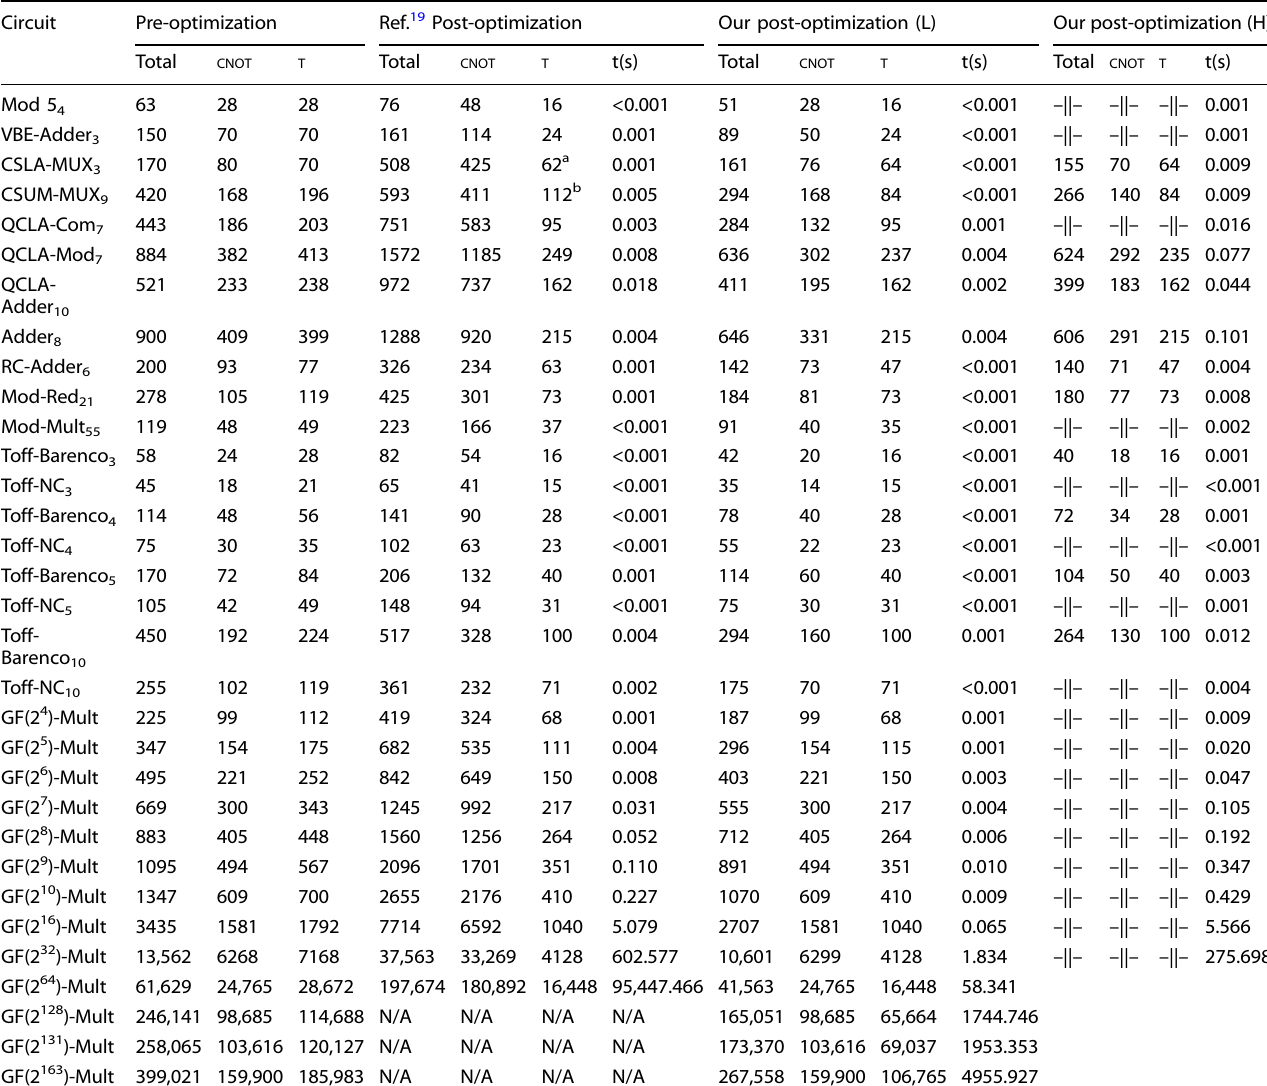
Table 4. T-par comparison Circuit Pre-optimization Ref. 19 Post-optimization Our post-optimization